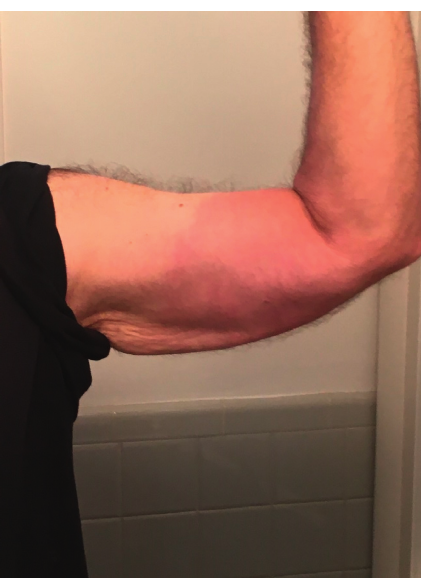
Figure 1: Photograph of patient’s erythema migrans skin